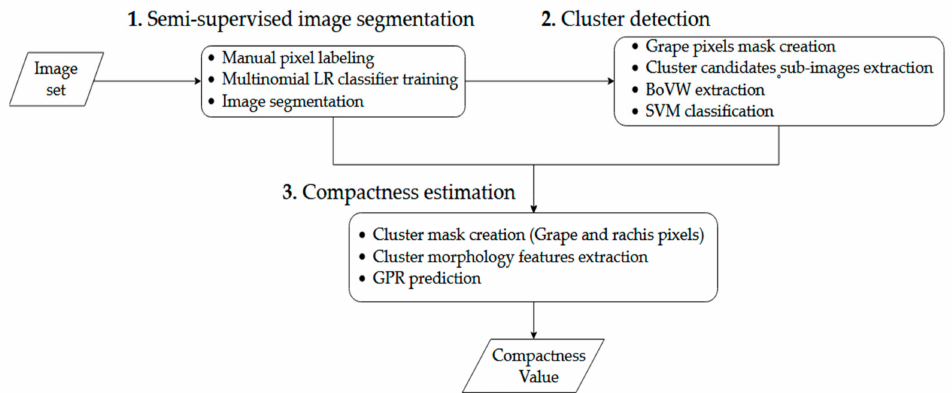
Figure 3. Flow-chart of the full algorithm for a new set of images. First, a set of pixel labeling was required to train a multinomial logistic regression model to segment the whole set. Second, the cluster candidates were extracted and filtered using a bag of visual words model. Finally, compactness features were extracted, and the estimation was performed on each cluster by the Gaussian process regression